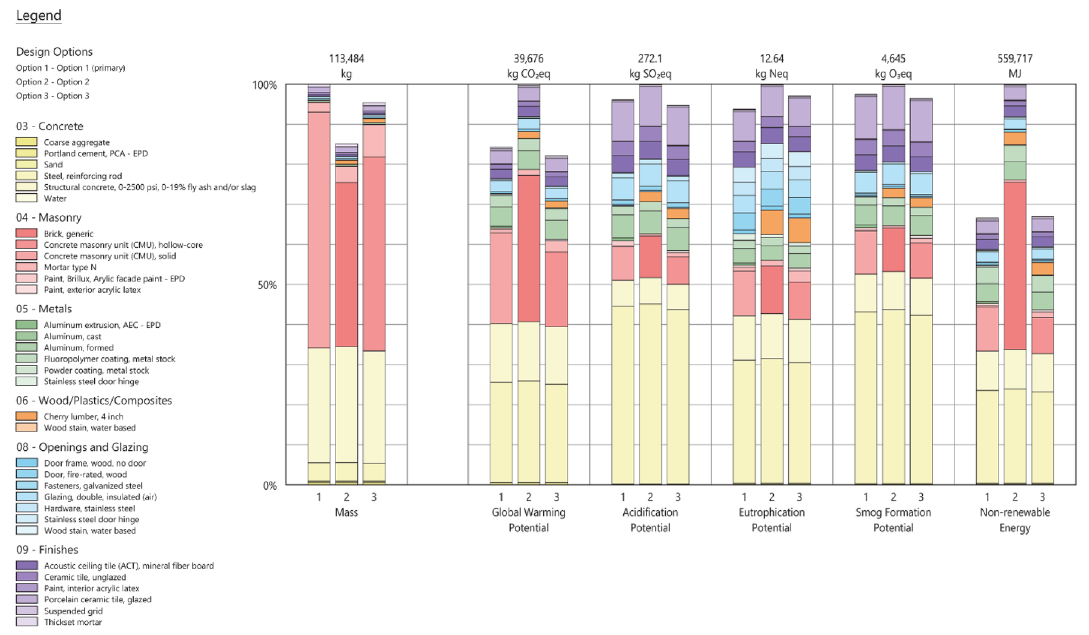
Fig. 7 LCA results itemised by